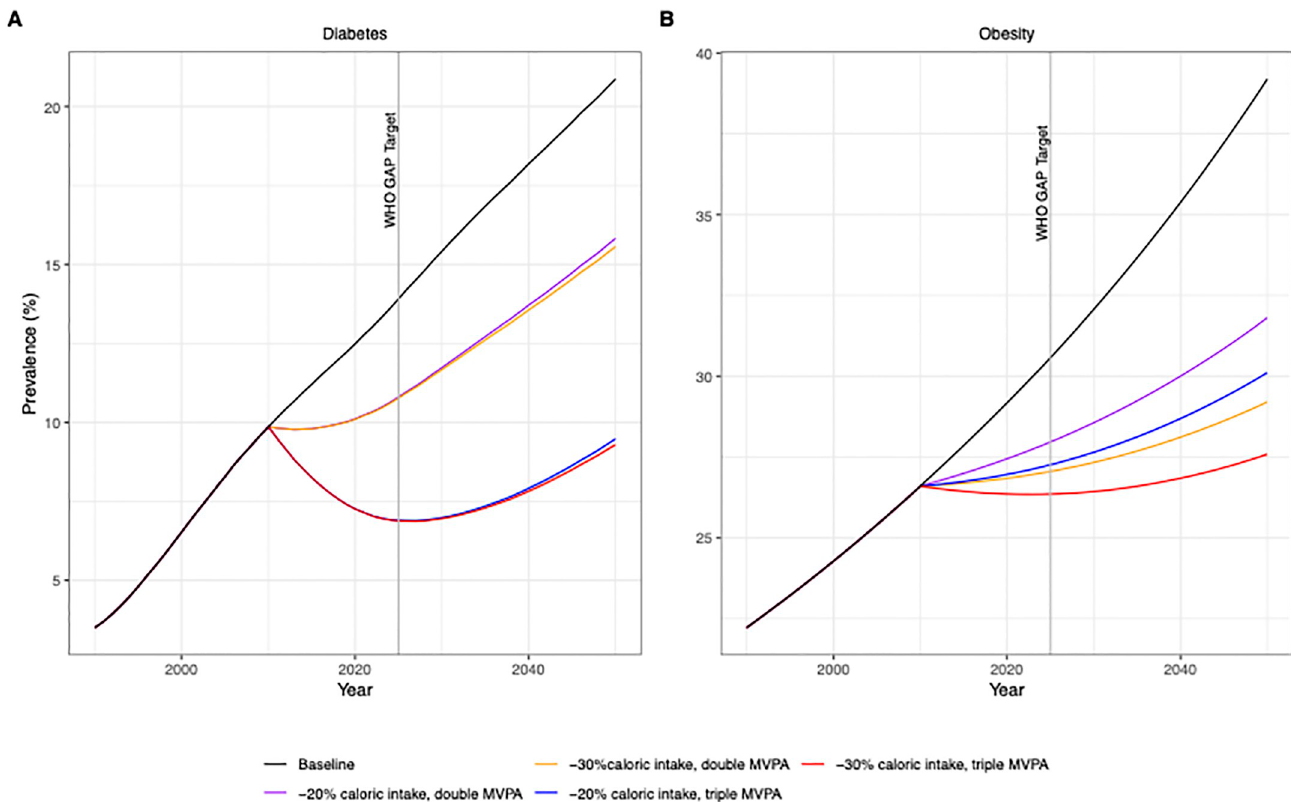
Fig 3. Scenarios for the magnitude of change in physical activity and caloric intake necessary to achieve global targets for diabetes (A) and obesity (B) prevalence (in adults 20+ years).